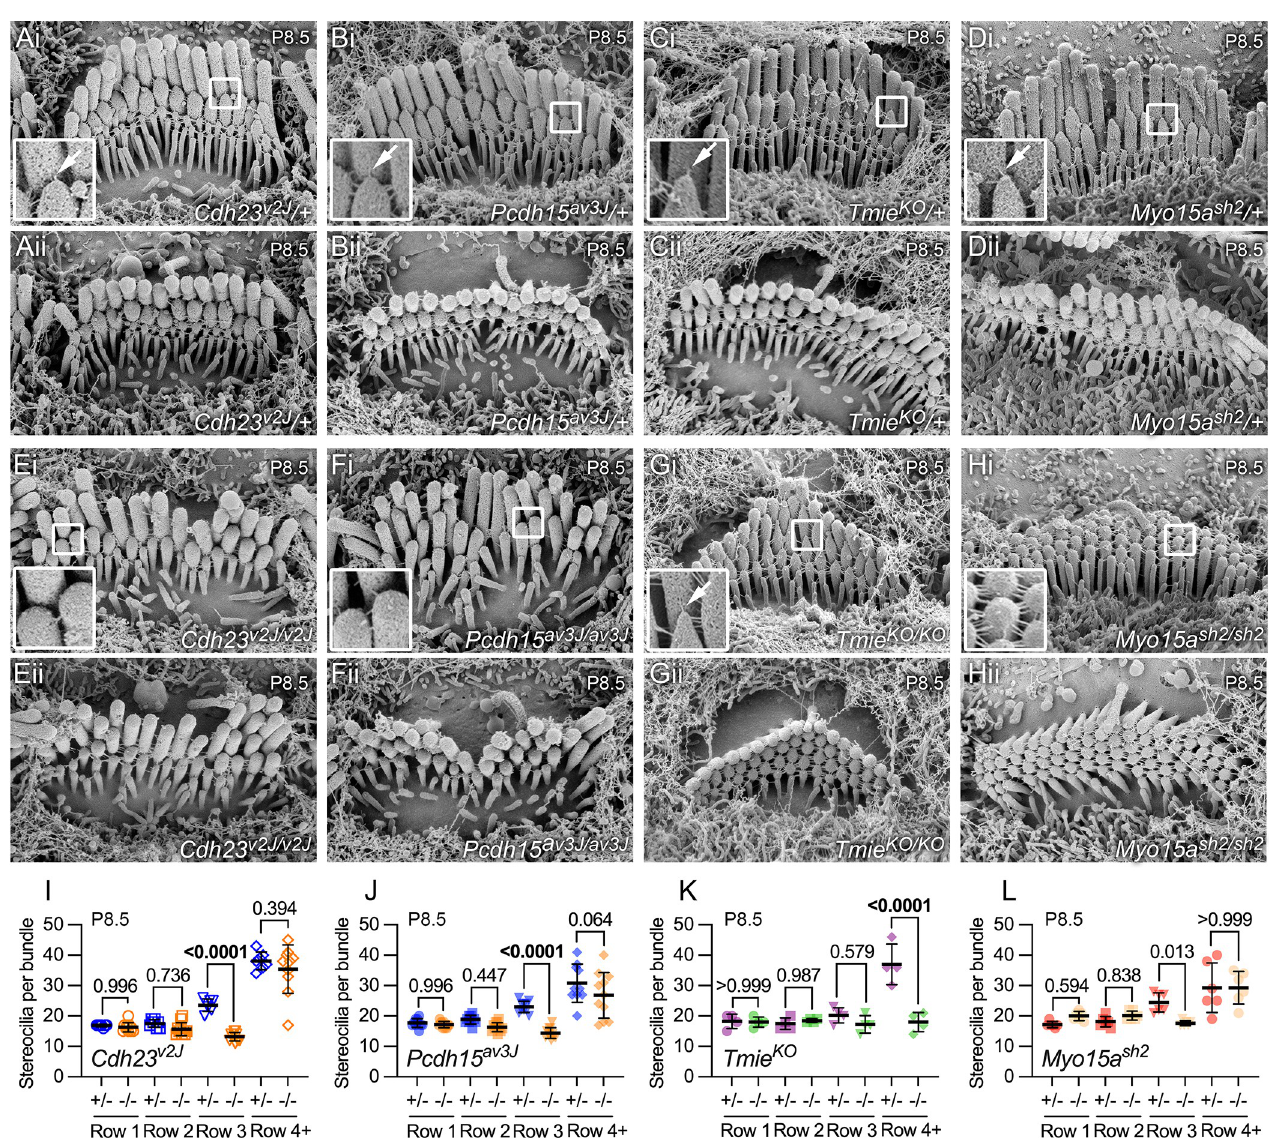
Fig 2. Scanning electron microscopy of mutants showing links and tip profiles. ( A–H ) Scanning electron micrographs of single IHC hair bundles from P8.5 cochleas of indicated genotypes. For each genotype, top panel (labeled i) is a profile example and bottom panel (ii) is a top-down example. The insets in Ai, Bi, Ci, Di, and Gi all provide examples of beveled or pointed stereocilia tips; the insets in Ei, Fi, and Hi provide example of rounded tips. Some links were still present in both Cdh23 v2J/v2J and Pcdh15 av3j/av3J bundles, but were not associated with beveled stereocilia tips. Panel widths, 6 μ m; inserts are 0.5 μ m wide and are magnified 3-fold on left. Arrows indicate tip links. ( I–L ) Quantitation of number of stereocilia per hair bundle from scanning electron micrographs. Rows 1, 2, and 3 separately plotted; additional rows of stereocilia and microvilli on each cell’s apical surface were also counted (row 4+). P values for unpaired t tests are indicated. The data underlying all the graphs shown in the figure can be found in figshare (https://doi.org/10.6084/m9.figshare.21632636.v2). IHC, inner hair cell.